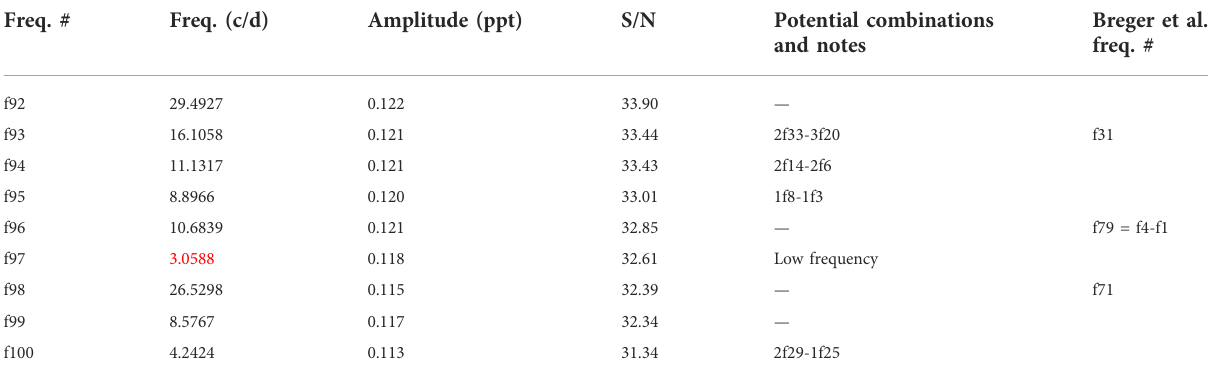
TABLE 2. ( Continued ) 100 highest S/N FG Vir TESS frequencies. Low frequencies between 0.3 and ~3 c/d are highlighted using red font. The calculated uncertainties in TESS frequencies and amplitudes, respectively, are 3.79×10 − 4 c/d and 9.82 ppm. Freq.